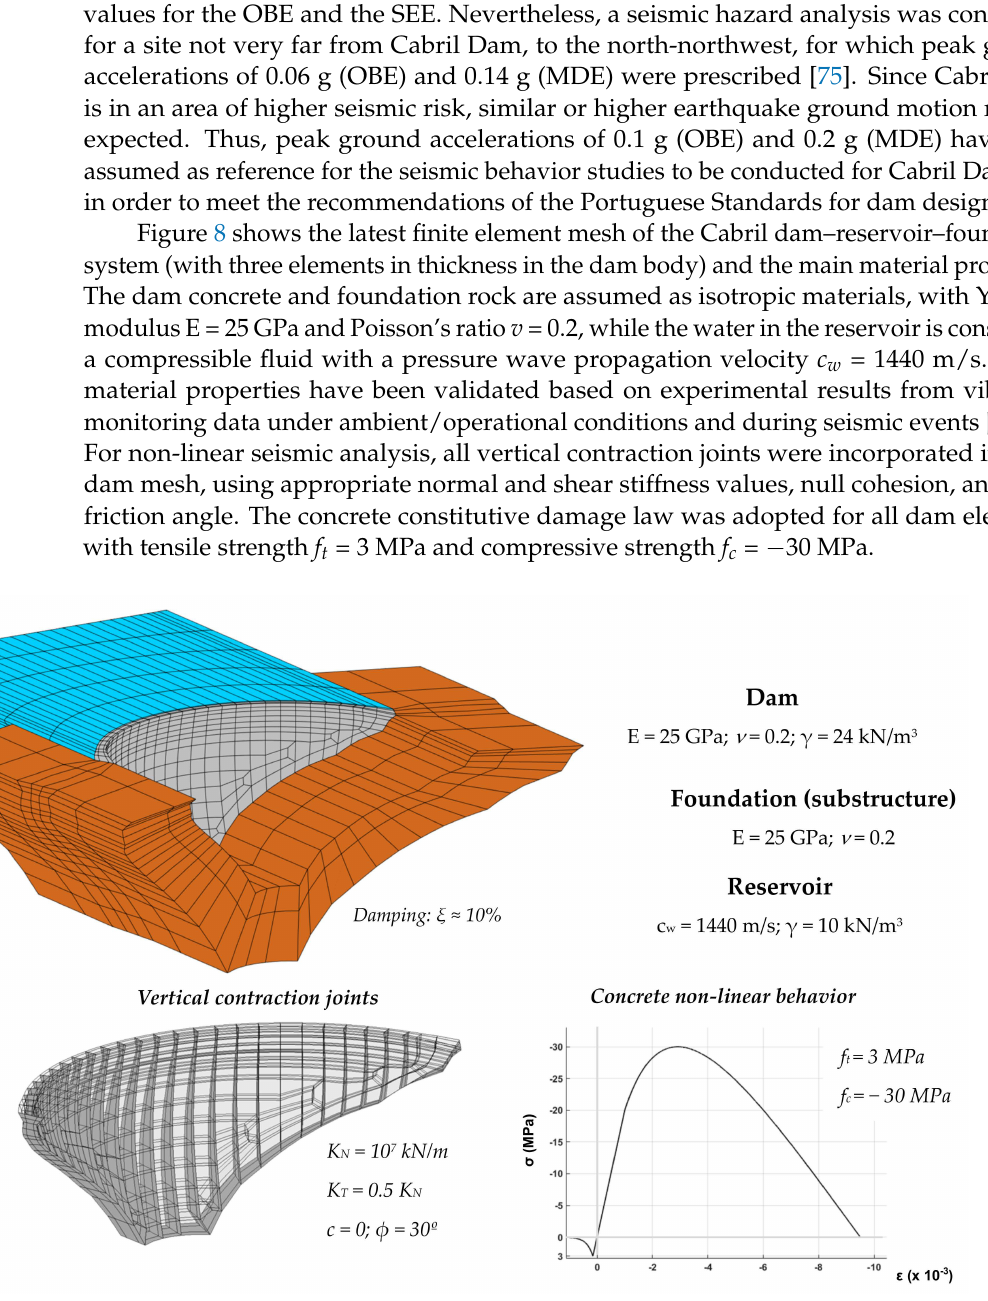
Figure 8. Finite element mesh and material properties used for dynamic analysis of Cabril